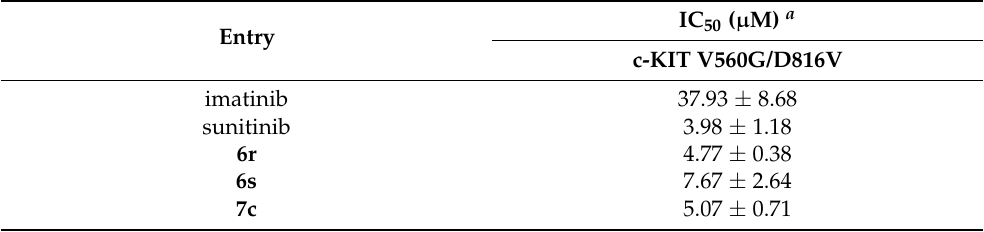
Table 3. Enzymatic inhibitory activities of thiazolo[5,4- b ]pyridine derivatives 6r , 6s , and 7c against c-KIT V560G/D816V.